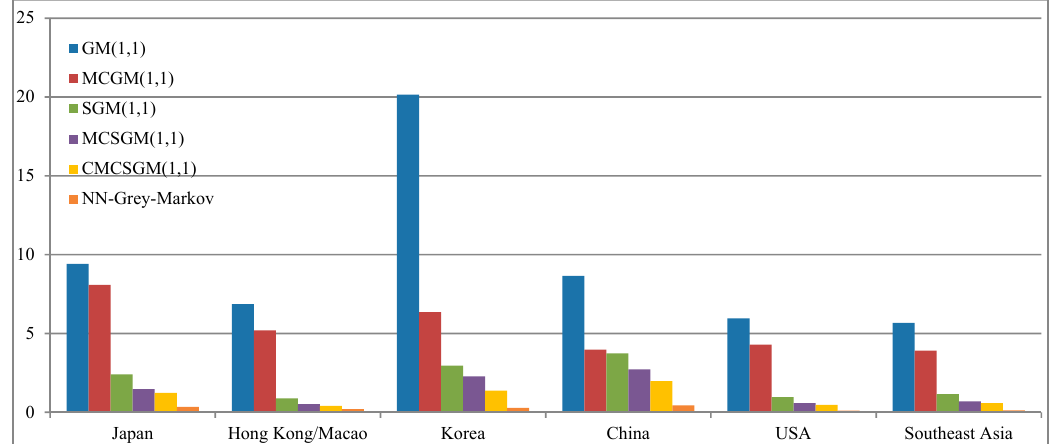
Figure 1. Model-fitting results for Case I.